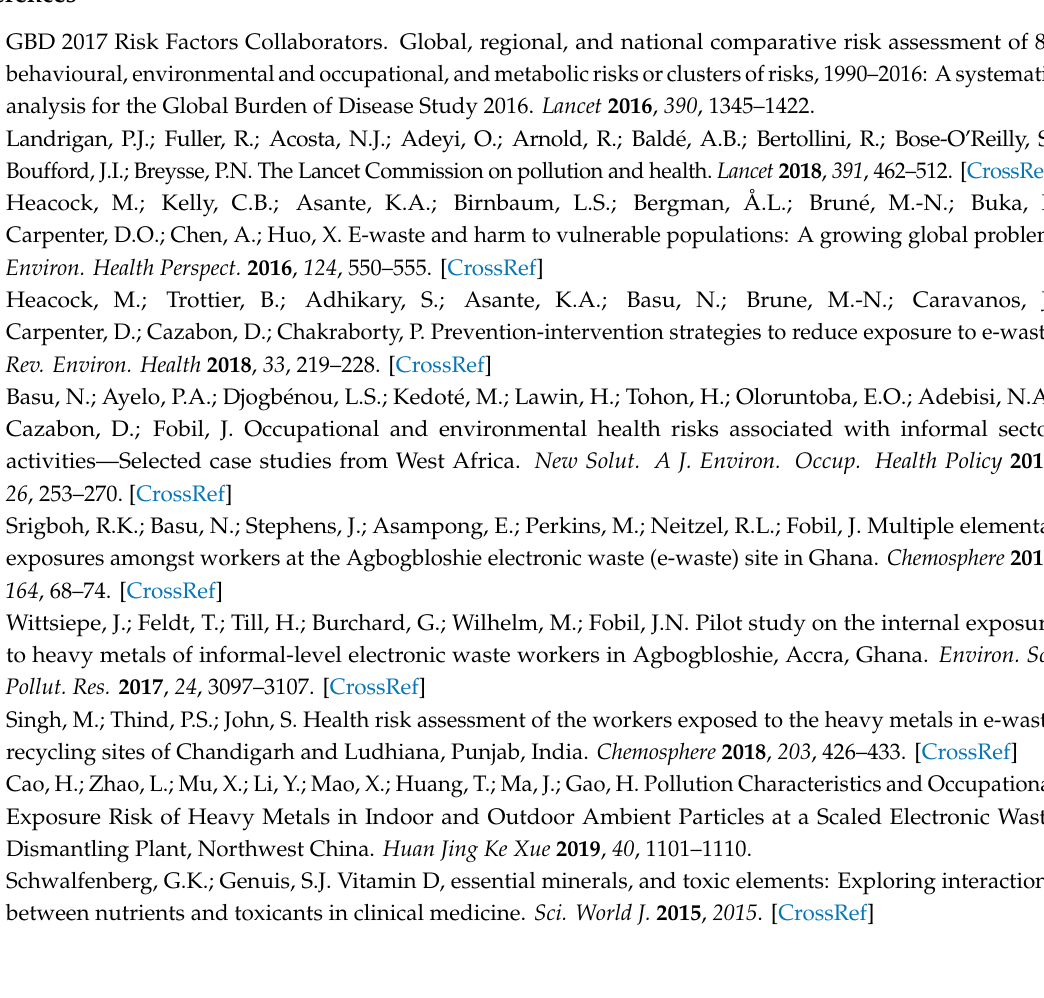
Table S1: Summary of elemental biomarker quality control measures, Table S2: Mean probability of